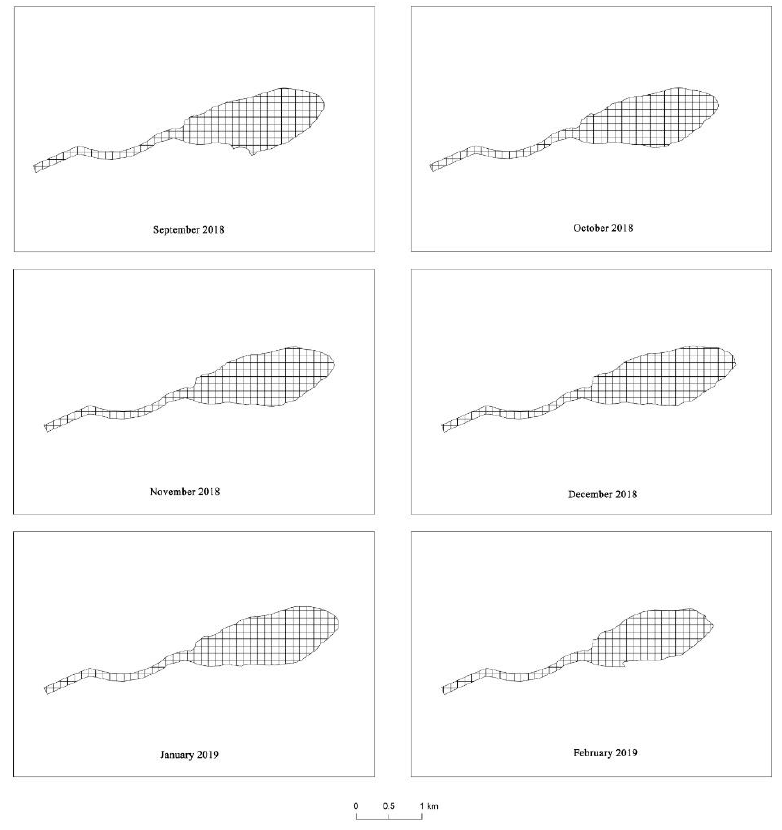
Figure A3. Areas of the Fu River–Baiyangdian Lake transition zone in each month. Numeric values are provided in Table 4.